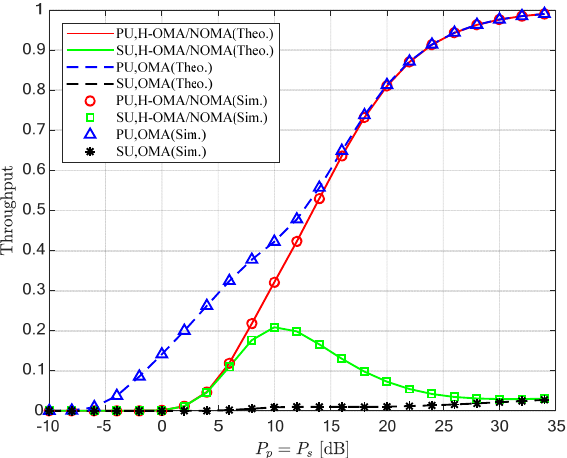
Figure 4. Throughput vs transmit power ( 𝑃 (cid:3017) = 𝑃 (cid:3020) ).